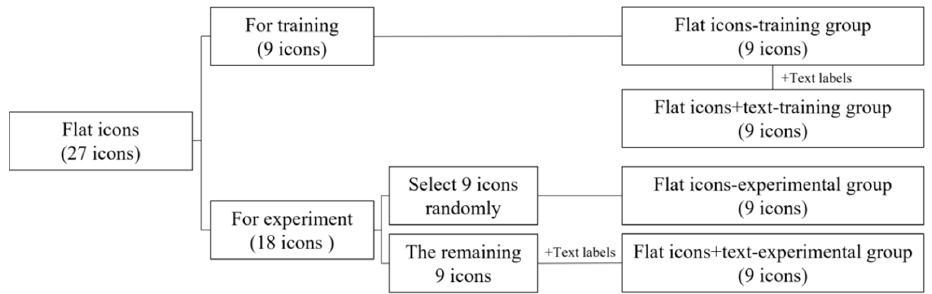
Figure 1. Flowchart showing the grouping of experimental materials.